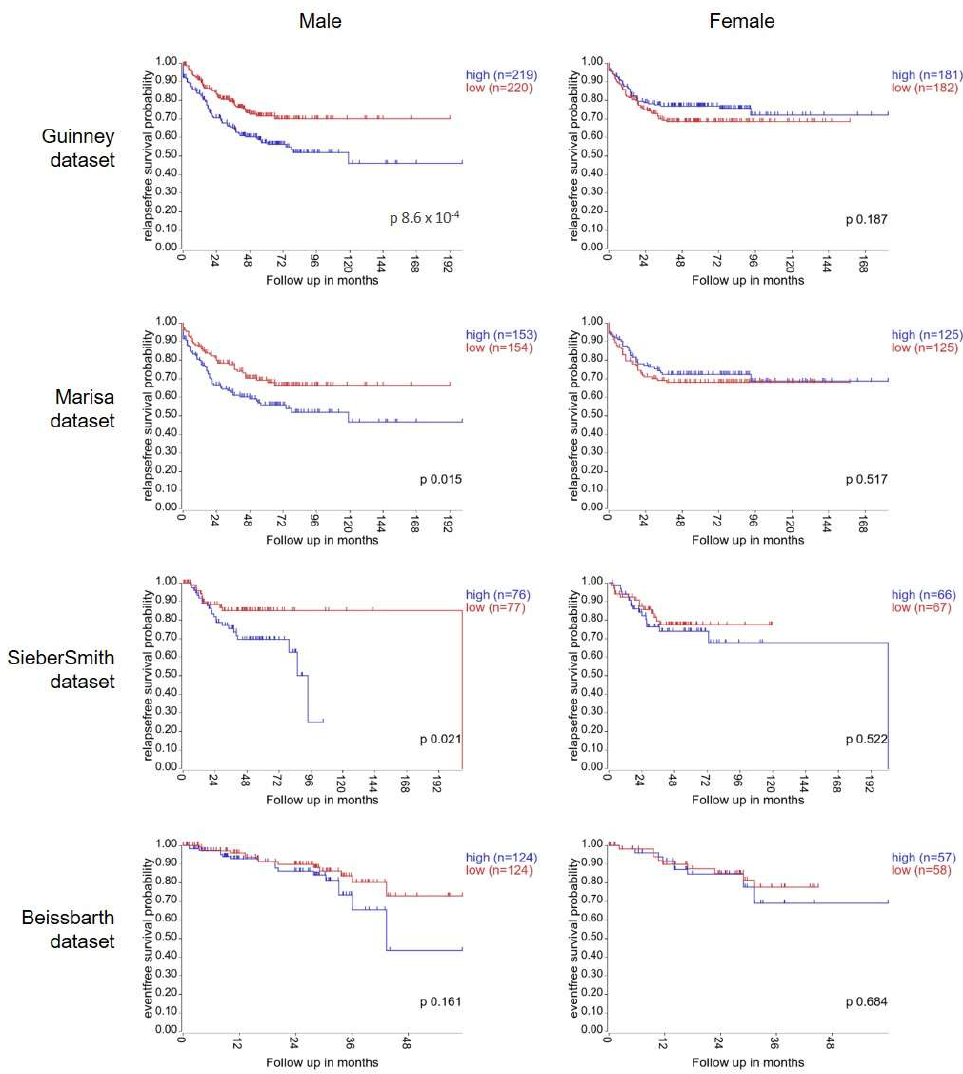
Figure 1. High gene expression of Wnt Receptor, FZD1 , associates with poor survival in male CRC patients but not in female CRC patients. Kaplan–Meier curves showing relapse-free survival rates (Guinney, Marisa and SieberSmith datasets) or event-free survival rates (Beissbarth dataset) for colorectal cancer patients with up to 200 months of follow up. Data from male patients are plotted on the left-hand side with female patients on the right-hand side. Patients were stratified into high and low expression of the Wnt receptor FZD1 , based on the median expression. p values were calculated with a log-rank test by the R2 bioinformatics webtool (http://r2.amc.nl (accessed on 23 May